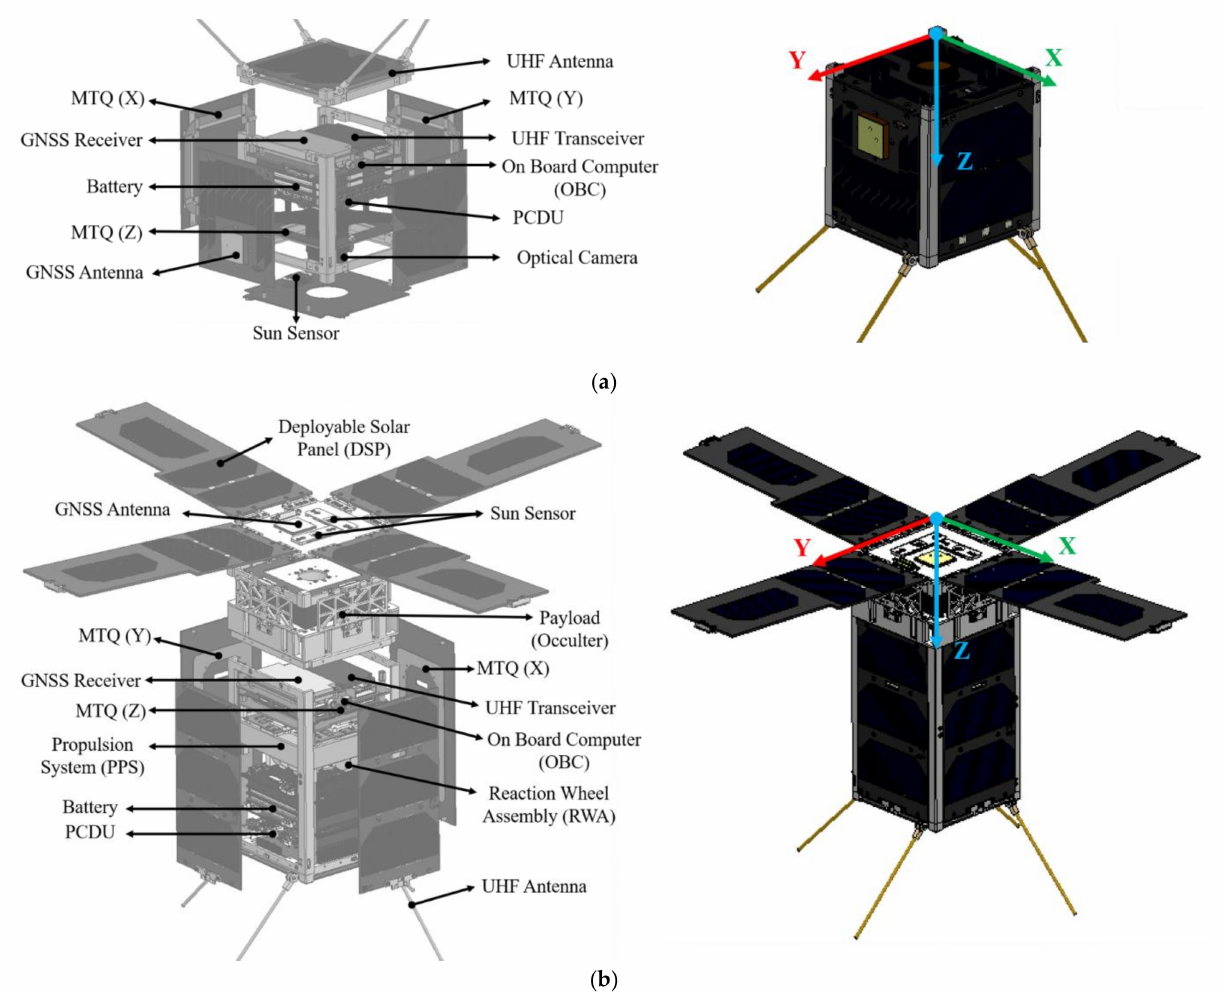
Figure 2. CubeSat hardware configuration and coordinate system: ( a ) 1U CubeSat, Timon; ( b ) 2U CubeSat, Pumbaa.